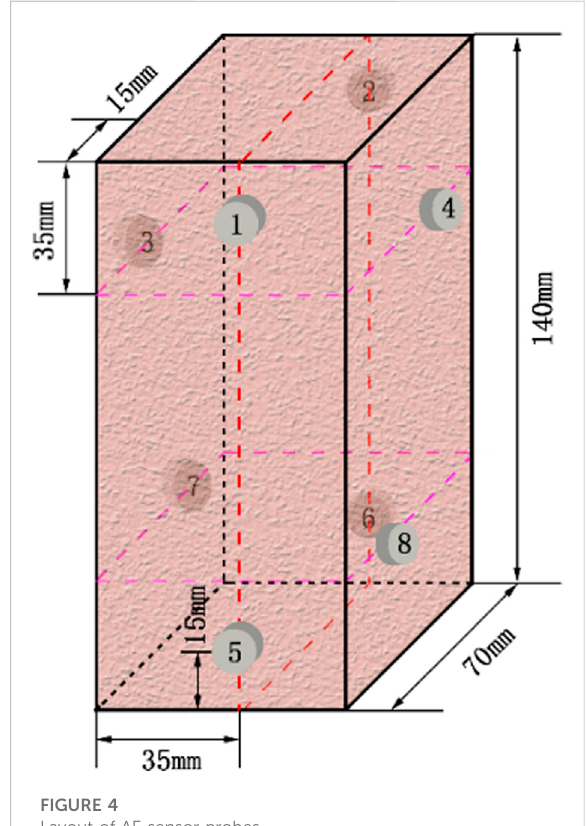
FIGURE 4 Layout of AE sensor